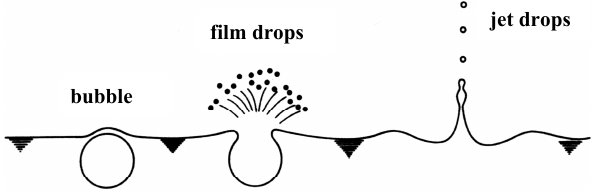
Fig. 1. Scheme of the two production ways of droplets from a burst- ing bubble; redrawn from Resch et al.